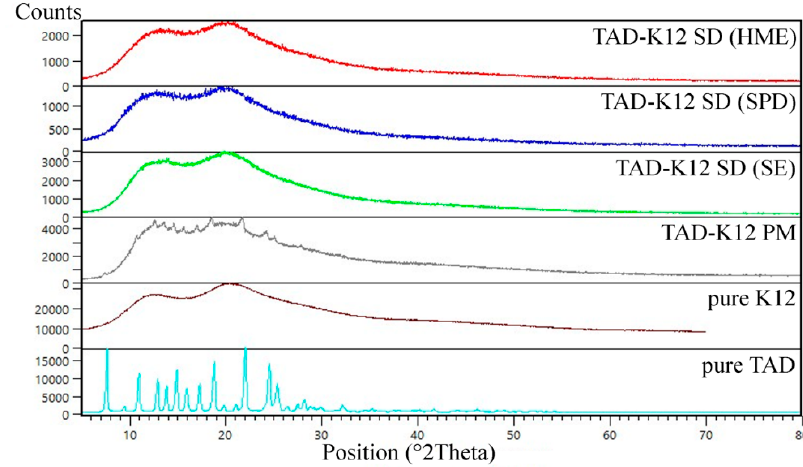
Figure 5. X-ray diffraction patterns of TAD, K12, their PM and SDs.